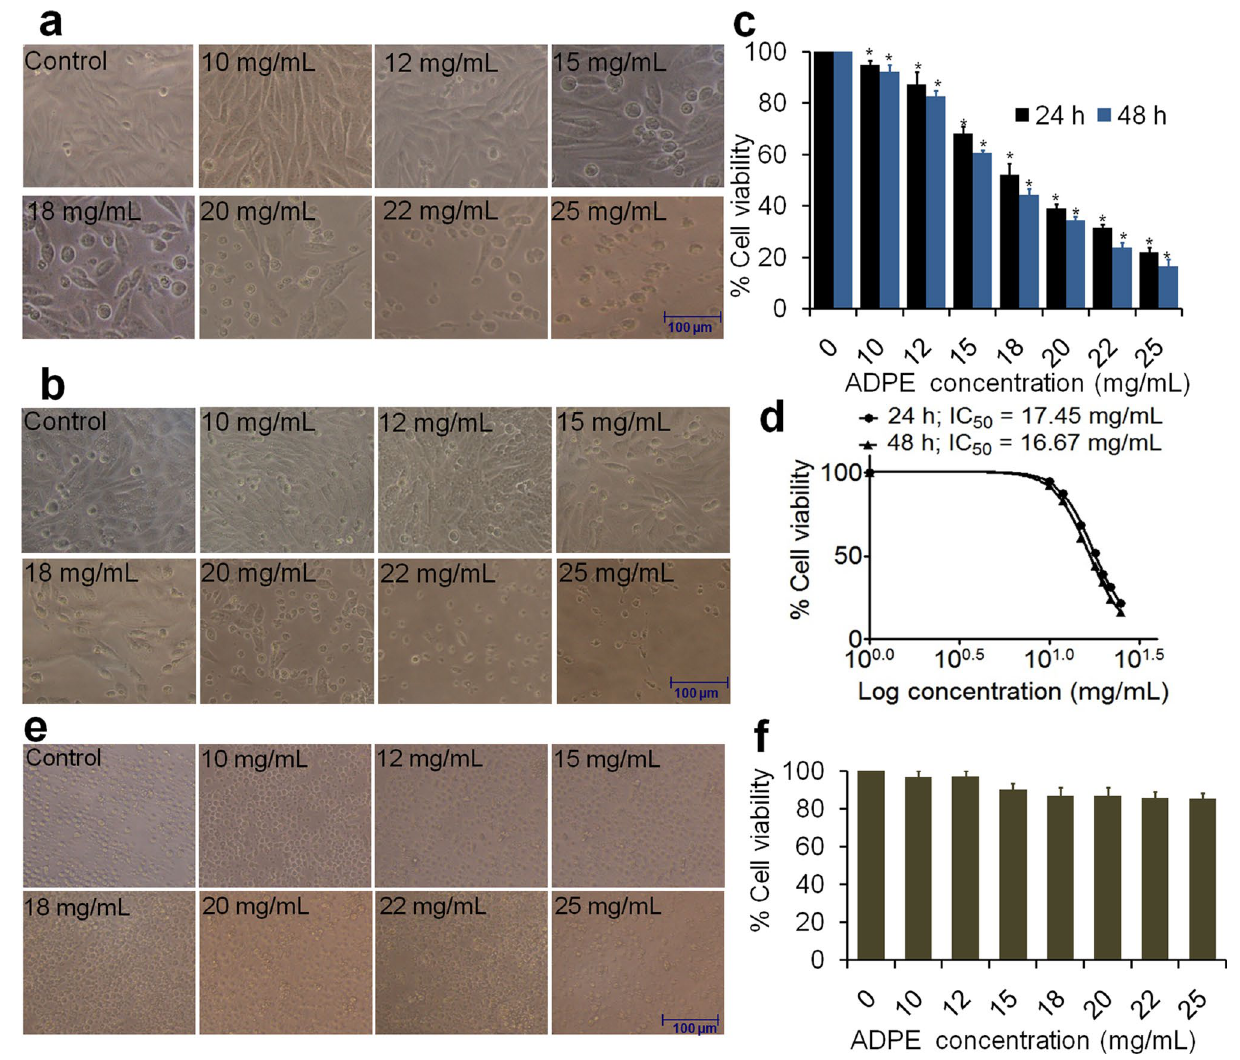
Figure 2. Microscopic observation and cytotoxic activity of different concentrations (10–25 mg/mL) of ADPE against MDA-MB-231 and PBMCs. ( a ) and ( b ) Photomicrograph of MDA-MB-231 cells treated with 10 to 25 mg/mL concentrations of ADPE at 24 and 48 h, respectively. Photomicrographs were taken with an inverted phase contrast microscope (Scale bar = 100 μm). ( c ) Percent cell viability of ADPE at various concentrations against MDA-MB-231 cells after 24 and 48 h incubation. ( d ) Dose response curve (Log concentration vs % cell viability) representing IC 50 values of ADPE at 24 and 48 h incubation. ( e ) Photomicrograph of PBMCs treated at various concentrations of ADPE at 24 h (Scale bar = 100 μm). ( f ) Percent cell viability of ADPE at various concentrations against PBMCs after 24 h incubation. Values are expressed as mean ± SEM of three independent experiments. * p < 0.05 as compared to be effective against various cancers 21 . In the present study, the evaluation of mitochondrial-mediated apoptosis, cell cycle arrest and underlying intracellular signaling pathways of cell death by ADPE against human TNBC MDA-MB-231 cells has been reported for the first time. The anti-proliferative effect of ADPE on MDA-MB-231 cell line has been shown in Fig. 1. The MTT results revealed that exposure of MDA-MB-231 cells to ADPE resulted in growth inhibition of cells in a dose- and time- dependent manner. ADPE showed IC 50 values of 17.45 and 16.67 mg/mL at 24 and 48 h, respectively. ADPE was also tested on normal human PBMCs to ascertain its toxicity. Interestingly, ADPE was found to be non-toxic without any associated morphological effects on PBMCs (Fig. 2e and f), which suggests that ADPE is non-toxic to normal human cells. As majority of the phytocomponents present in the pulp of Ajwa dates were characterized as polysaccharides in LC–MS, therefore, larger proportions are needed to elicit biological efficacy of ADPE. This study suggests that consumption of large portions of Ajwa dates may be conducive to lead a healthy and cancer- free life. The morphological data under inverted phase-contrast microscopy revealed the natural and fibroblastic morphology of untreated TNBC cells. ADPE caused a decrease in the number of cells by an alteration in their shape and adherence. These events represent the classical features of early apoptosis 22 . Further, to confirm apop- totic cell death, MDA-MB-231 cells were investigated using Hoechst 33342 nuclear stain under a fluorescence